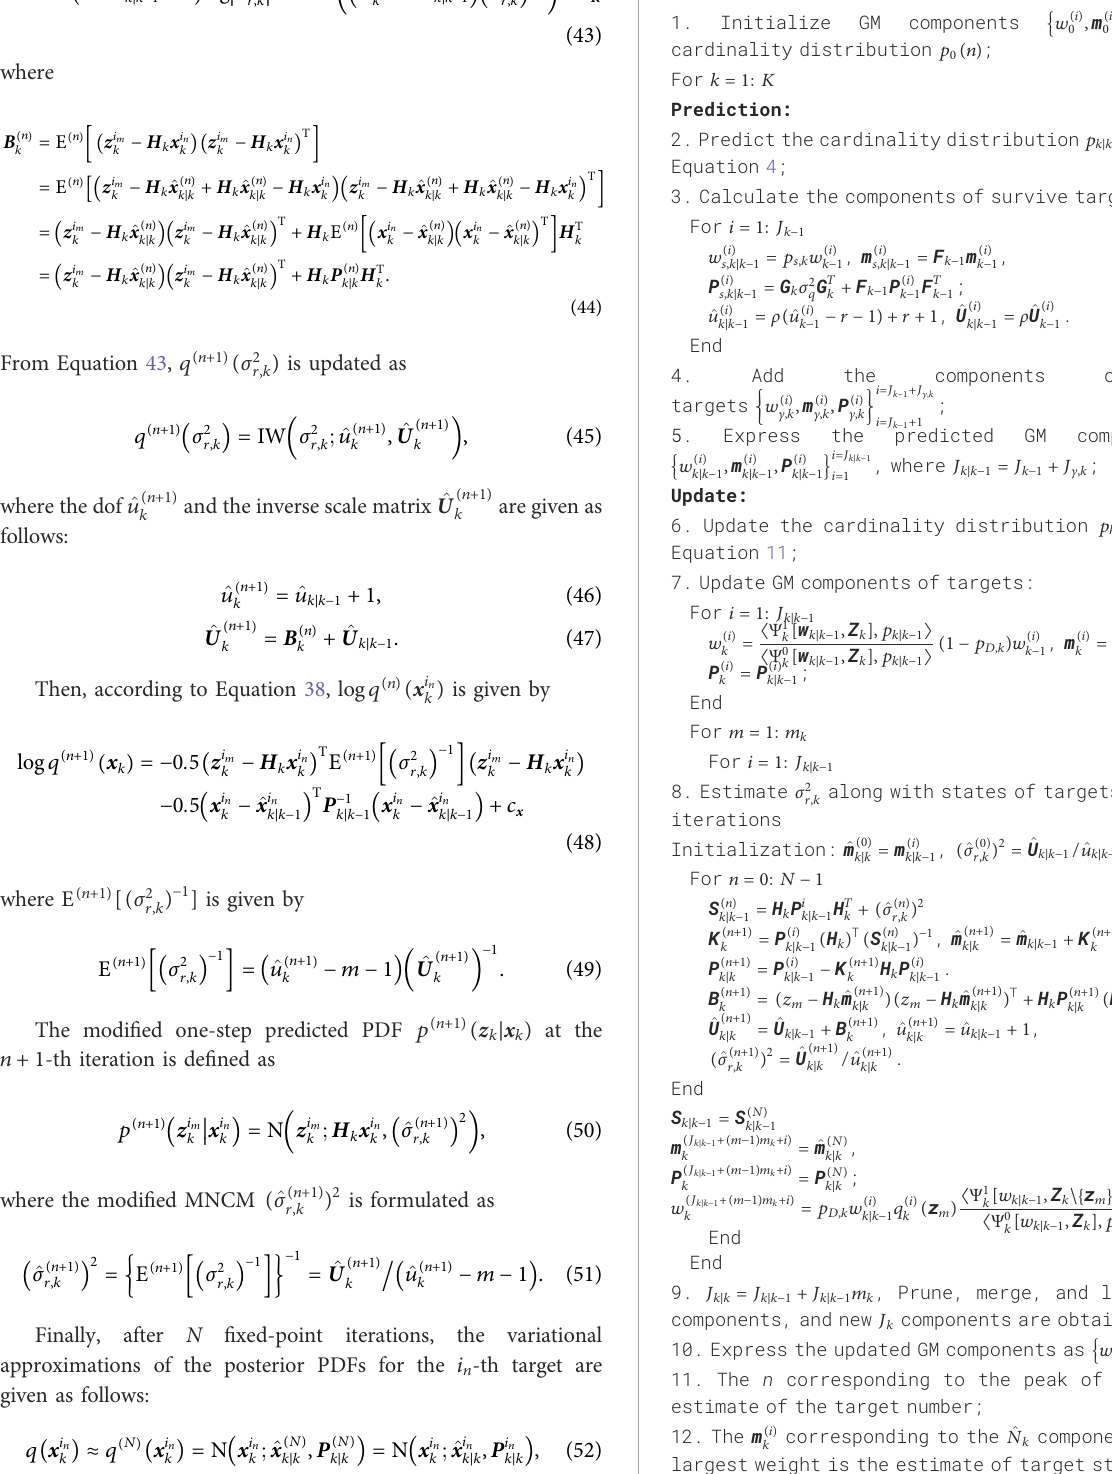
Algorithm 1. VB-CPHD fi lter for Robust multi-target DOA